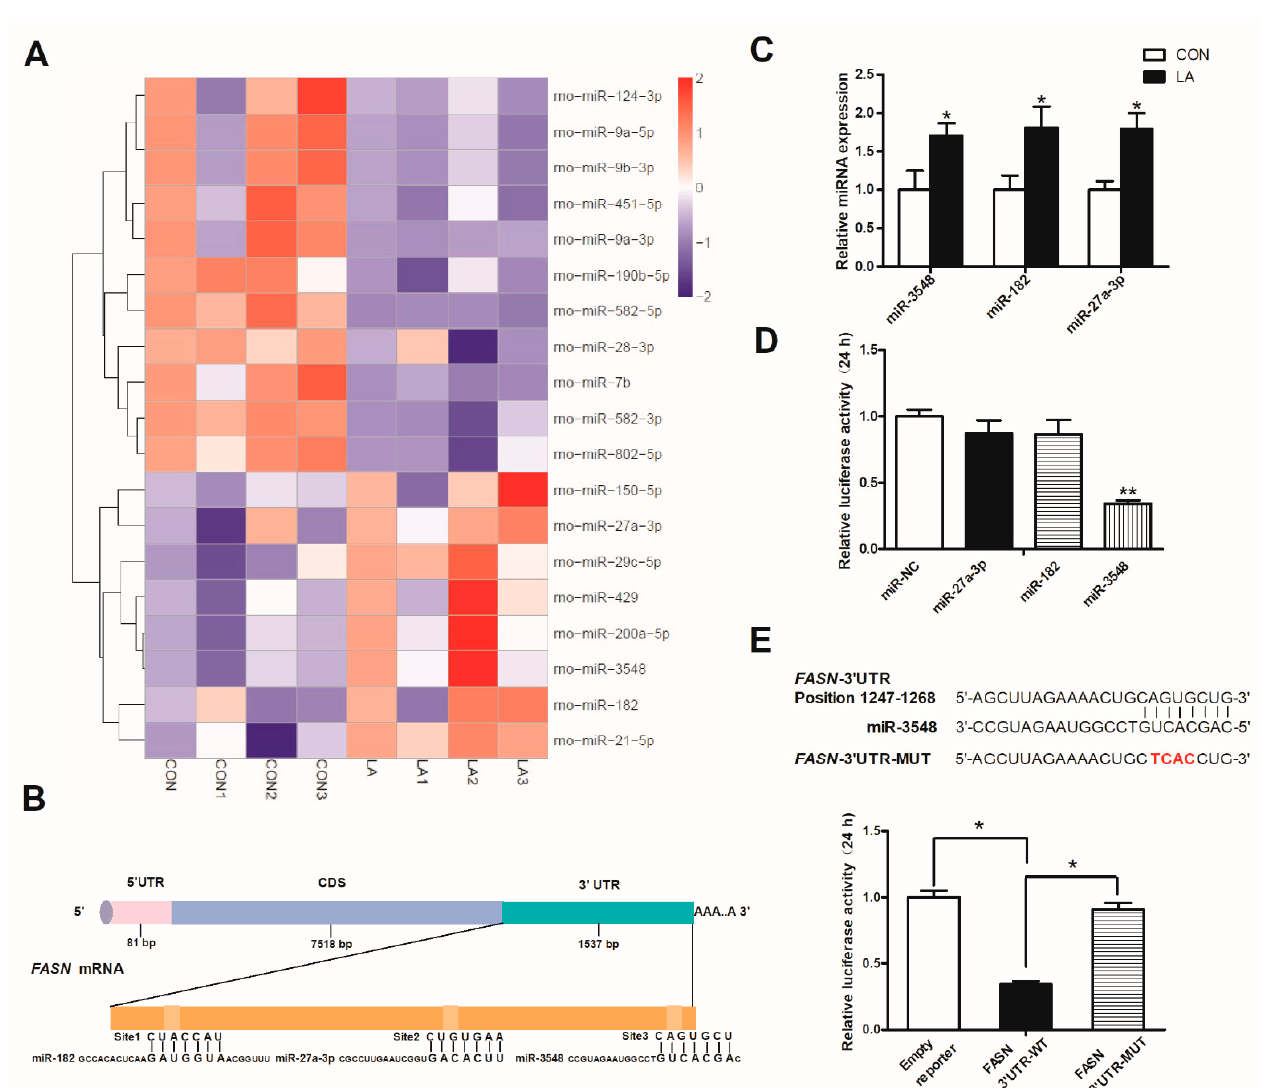
Figure 5. α -Lipoic acid downregulates FASN expression through miRNA-3548 in the liver. ( A ) Heatmap of miRNA expression profiles based on miRNA sequencing. ( B ) Predicted binding sites of miR-27a-3p, miR-3548, and miR-182 in the 3 (cid:48) UTR of Fasn mRNA. ( C ) qRT-PCR analysis of hepatic miR-3548, miR-182, and miR-27a-3p expression. ( D ) Relative luciferase activity was detected when HEK-293T cells were co-transfected with the Fasn 3 (cid:48) UTR reporter and NC, miR-27a-3p, miR-182, or miR-3548 mimics for 24 h, the global ANOVA p -value < 0.01. ( E ) HEK-293T cells were co-transfected with miR-3548 and either the empty vector, wild-type, or binding site mutant-reporter and luciferase activity was measured 24 h post-transfection, the global ANOVA p -value < 0.01. CON: Control diet, LA: Control diet+ alpha-lipoic acid. Values are expressed as mean ± SEM, n = 6 in each group, * p < 0.05, ** p < 0.01.